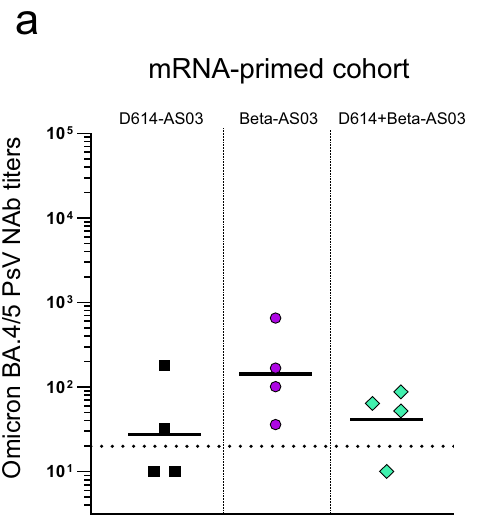
ancestral D614 vaccine, Beta vaccine, or bivalent ancestral+Beta vaccine. Indivi- dual macaque data were shown with geometric mean titers (GMTs). Horizontal dotted lines represent the limit of quanti fi cation of the assay.